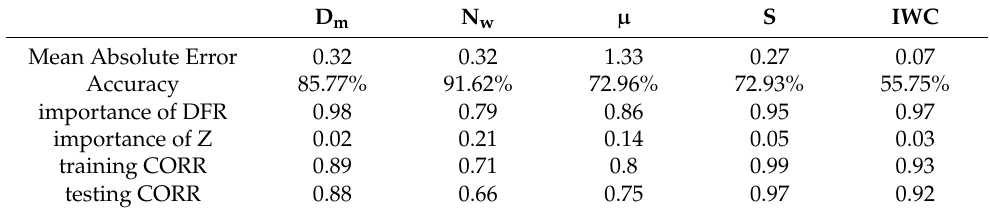
Figure 5. Scatterplots of PSD-observed and retrieved D m ( a ), N w ( b ), µ ( c ), S ( d ), and IWC ( e ) from training (left) and testing (right). The black line is y = x. Table 4. Mean absolute error, accuracy, importance of DFR, importance of Z, correlation coefficient of the training model, and correlation coefficient of the testing model.